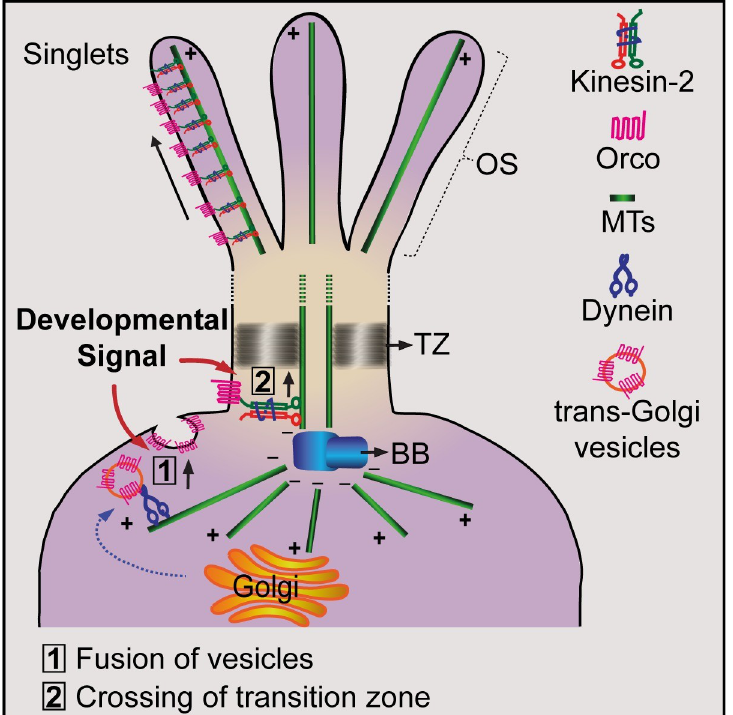
Fig 9. Model for Orco transport by kinesin-2 motor protein. Targeting of vesicles carrying receptor proteins from the trans-Golgi network to the ciliary base is brought about by dynein motor and other accessory ciliary trafficking proteins like Rab-GTPases (Rab11, Rab8) along with their GEFS, and also BBSome protein complex. Our results indicate that once the receptor proteins (Orco) are targeted to the ciliary base, heterotrimeric kinesin-2 interacts with Orco and facilitates the transition of the Orco across the ciliary barrier/transition zone into the ciliary OS. Kinesin-2 also helps localise Orco in a defined domain in the distal region of the ciliary